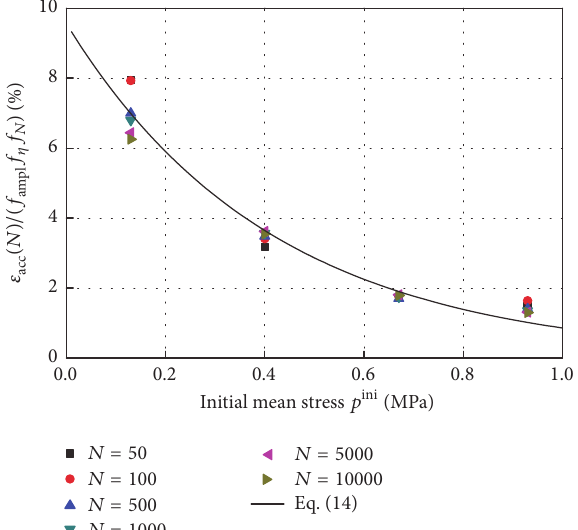
Figure 15: Normalized accumulated axial strain versus number of load